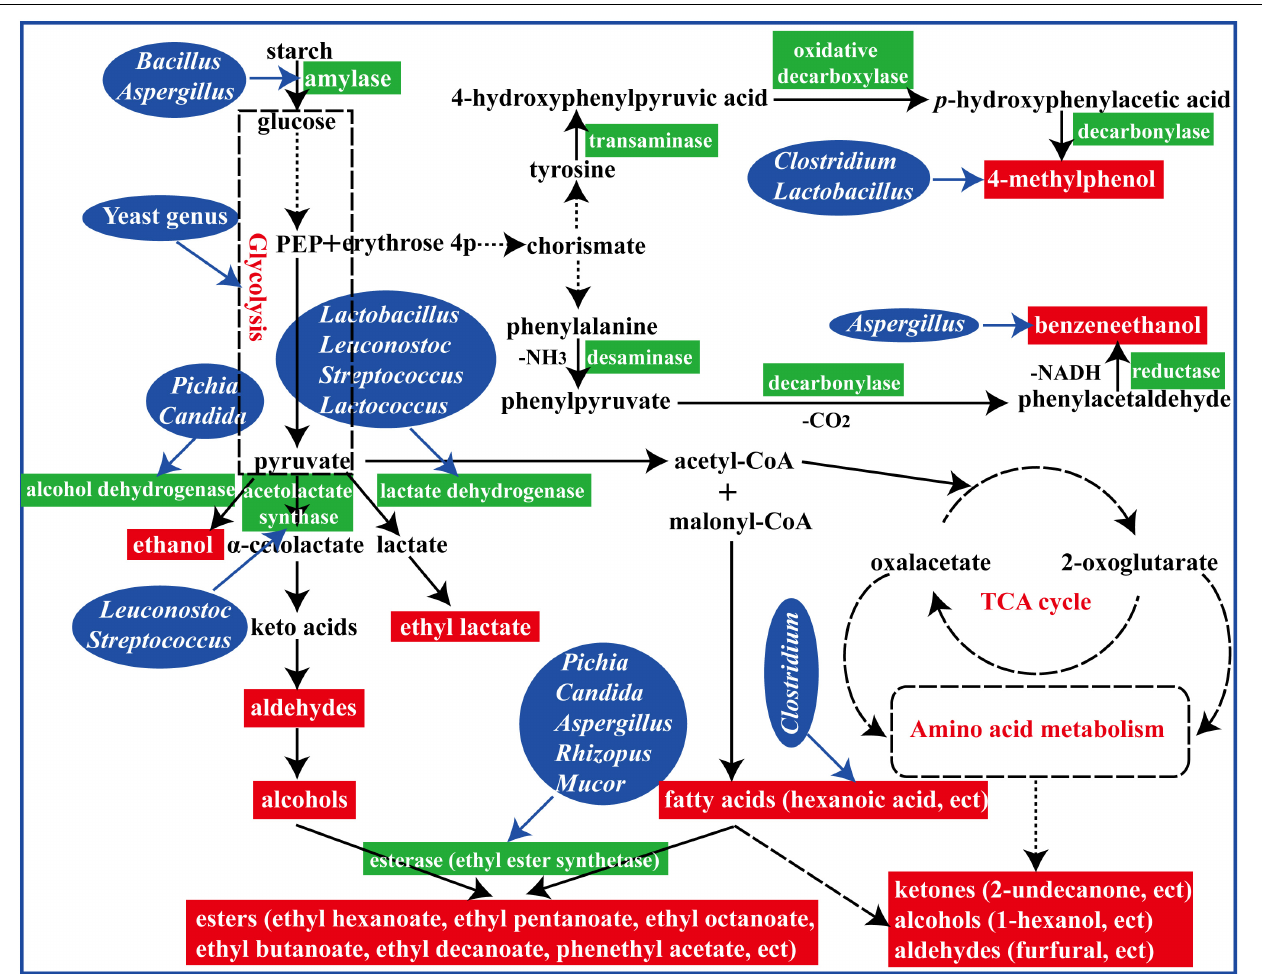
FIGURE 7 | A schematic representation of formation of flavor compounds by microbial metabolism in the brewing